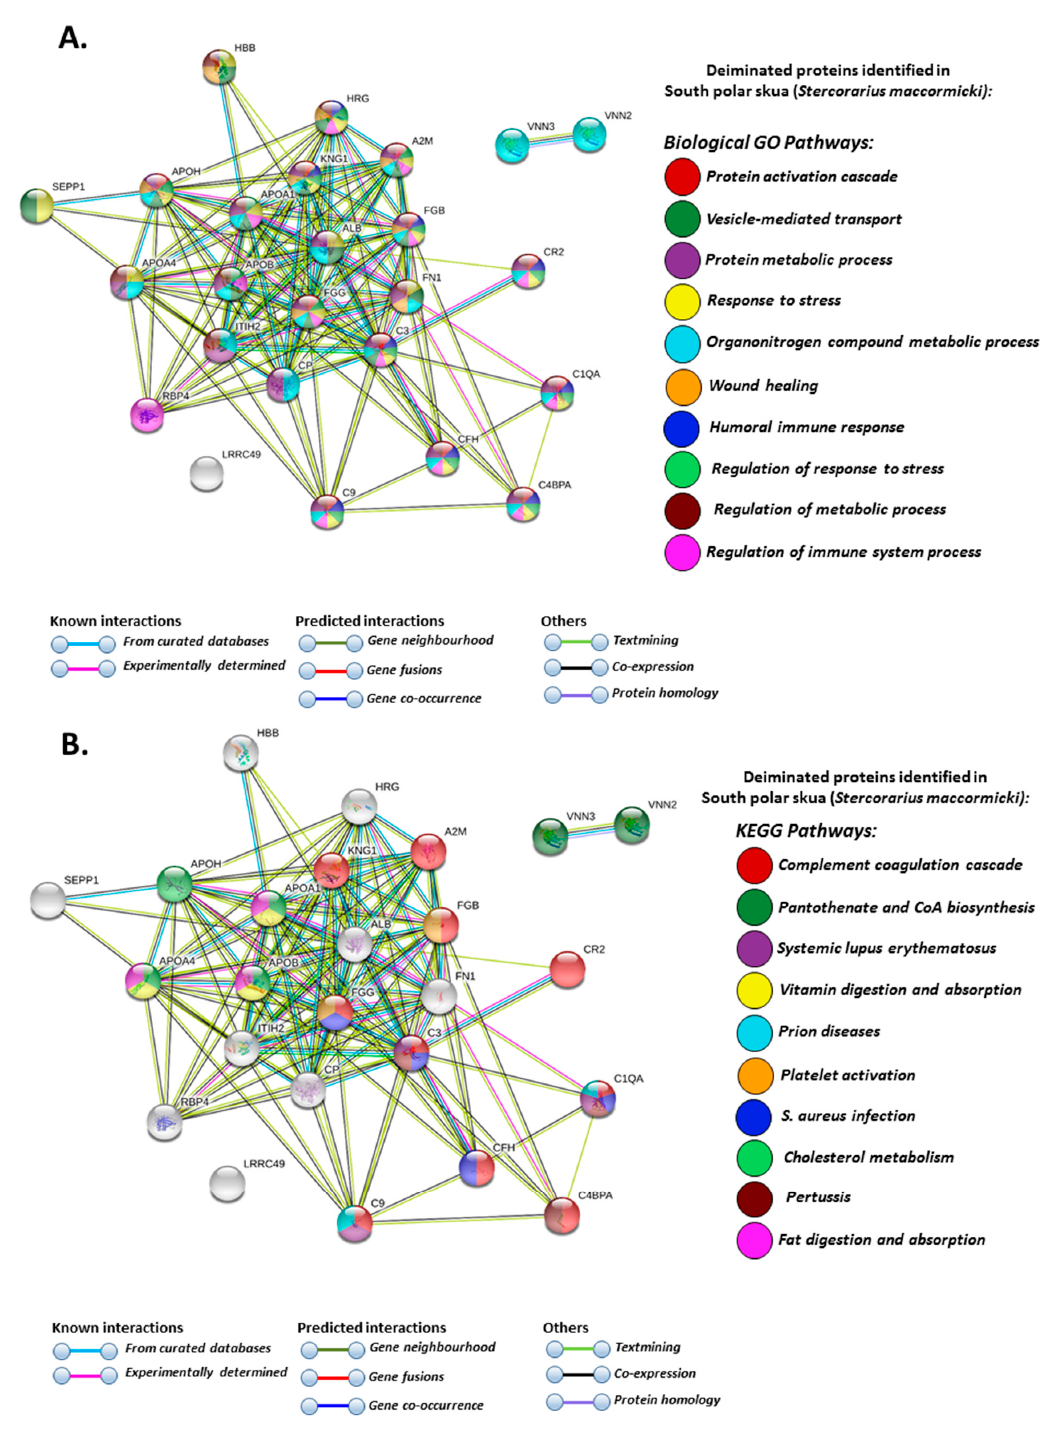
Figure 6. Protein–protein interaction networks of deiminated proteins identified by F95 enrichment in plasma of south polar skua ( Stercorarius maccormicki ). Reconstruction of protein–protein interactions based on known and predicted interactions of human homologue proteins to proteins identified in south polar skua, using STRING analysis. ( A ) Biological GO pathways relating to identified proteins and reported in STRING are highlighted showing protein activation cascade; vesicle-mediated transport; protein metabolic process; response to stress; organonitrogen compound metabolic process; wound healing; humoral immune response; regulation of response to stress; regulation of metabolic process and regulation of immune system process. ( B ) KEGG pathways relating to the identified proteins and reported in STRING are highlighted showing complement and coagulation cascade; pantothenate and CoA biosynthesis; systemic lupus erythematosus; vitamin digestion and absorption; prion diseases; platelet activation; Staphylococcus aureus infection; cholesterol metabolism; pertussis and fat digestion and absorption. Coloured nodes represent query proteins and first shell of interactors; white nodes are second shell of interactors. Coloured lines indicate whether protein interactions are identified via known interactions (curated databases, experimentally determined), predicted interactions (gene neighbourhood, gene fusion, gene co- occurrence) or via text mining, co-expression or protein homology (see the colour key for connective lines and for nodes indicating the specific GO and KEGG pathways included in the figure). In the wandering albatross only, specific deimination positive pathways were identified involving biological GO pathways for post-translational modification, plasma lipoprotein particle remodelling and KEGG pathways for Chagas disease, regulation of actin cytoskeleton and extracellular matrix (ECM) receptor interaction (Figure 7A,B).